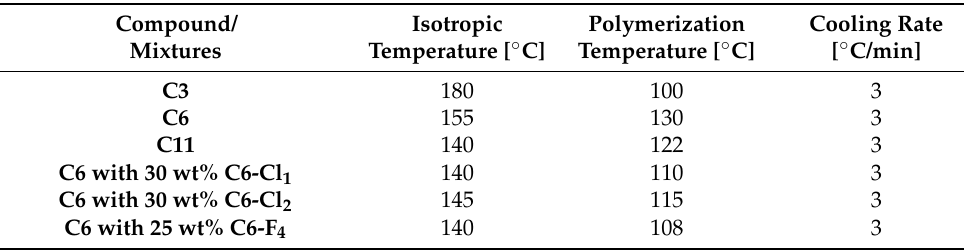
Table 1. Fabrication conditions for LC membranes with various layer spacings and LC membranes with various halogenated LCs. Compound/ Isotropic Polymerization Cooling Rate Mixtures Temperature [ ◦ C] Temperature [ ◦ C] [ ◦ C/min] C3 180 100 3 C6 155 130 3 C11 140 122 3 C6 with 30 wt% C6-Cl 1